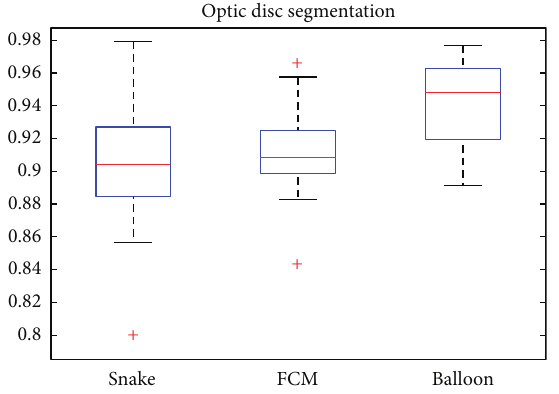
Figure 15: Optic disc segmentation results over 30 images.